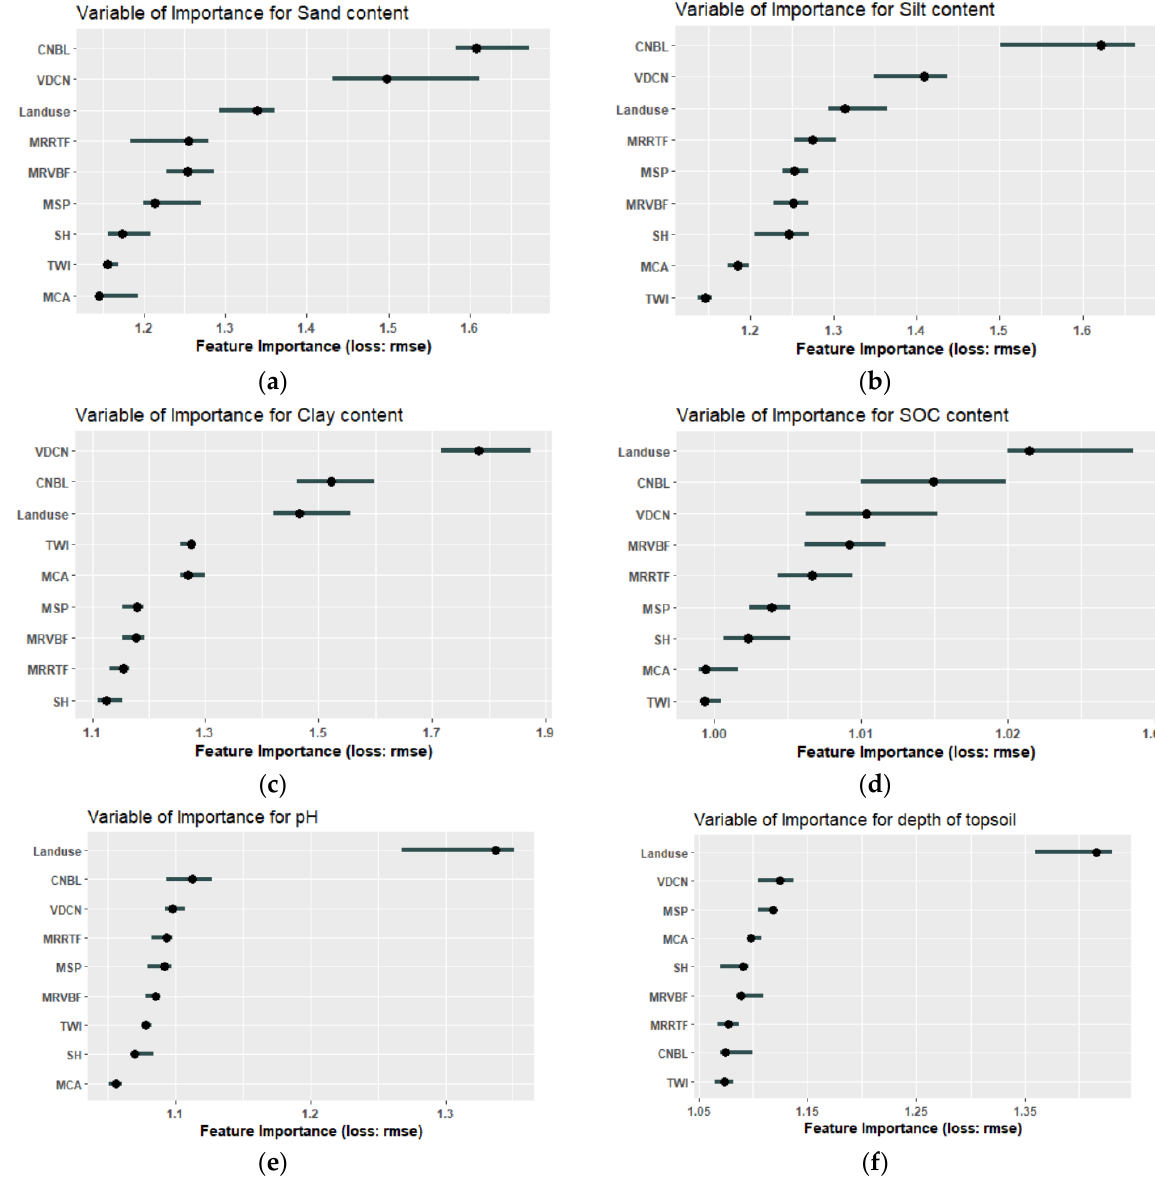
Figure 5. ( a – f ) Variable importance for different soil parameters derived by the best performing model.